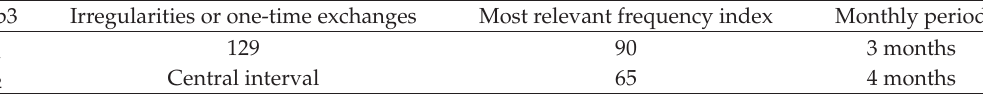
Table 4: Fourth assumption. Relevant frequency indices of Spain INDEX after data added in the sensitivity analysis.